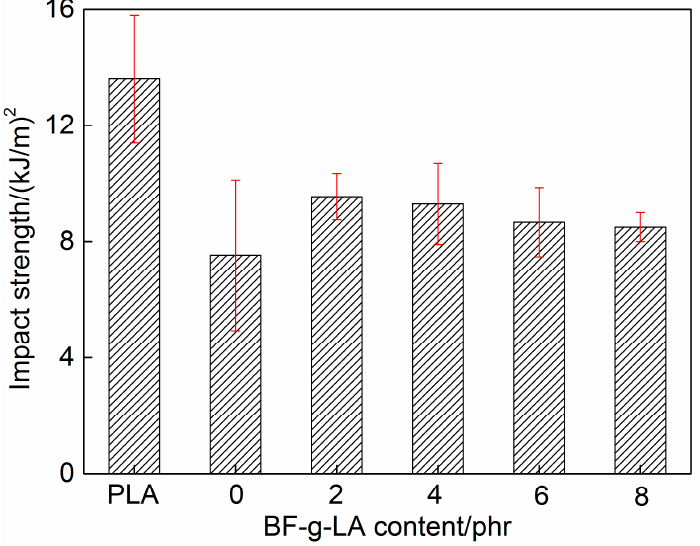
Figure 6. Impact strength of PLA/BF/BF- g -LA composites.